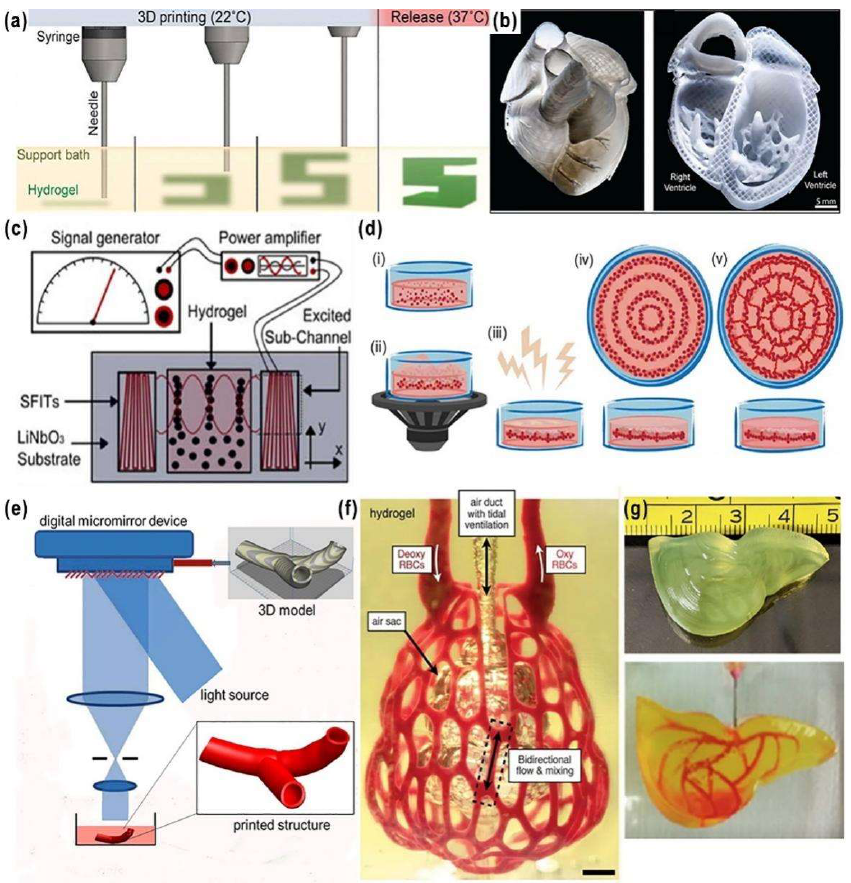
Figure 7. ( a ) A schematic of the FRESH process showing the hydrogel ( green ) being extruded and cross-linked within the gelatin slurry support bath ( yellow ). The 3D object is built layer-by-layer and, when completed, is released by heating to 37 °C and melting the gelatin, reported by Hinton et al. Reprinted from Ref. [75]. ( b ) A FRESH-printed collagen heart ( left ), and cross-sectional view of the collagen heart ( right ), showing the left and right ventricles and interior structures, reported by Lee et al. Reprinted with permission from Ref. [76]. Copyright © 2023, The American Association for the Advancement of Science. ( c ) Schematic description of the acoustic printing device, based on surface acoustic waves (SAW), reported by Naseer et al. Reprinted from Ref. [77]. ( d ) Sound-induced morphogenesis (SIM) based on Faraday waves, ( i – v ) are schematic diagrams of the formation of vascular network, reported by Petta et al. Reprinted from Ref. [78]. ( e ) Stereolithog- raphy bioprinting of branch blood vessels. ( f ) A vascularized alveolar model topology, reported by Grigoryan et al. Reprinted from Ref. [79]. ( g ) A liver model with smooth surface and monolithic, translucent hydrogel body, in which, a vascular channel network was filled, stained with rhoda- mine B and visualized under fluorescence, reported by Anandakrishnan et al. Adapted from Ref. [80]. More recently, some other teams have also used this technique to print vascular tissues. For example, Lee et al. printed human heart components at various scales, from capillaries to whole organs in 2019 [76]. The obtained 3D constructs include neonatal ca- pillaries of less than 10 μm, complex vasculatures, ventricular and tri-leaflet heart valves, and neonatal-scale human hearts (Figure 7b). The resolution of the FRESH printing can be increased in the supportive bath using a coacervation approach, resulting in a vascu- lature with denser networks and smaller diameters, including perfusable vessels around 100 μm in diameter.